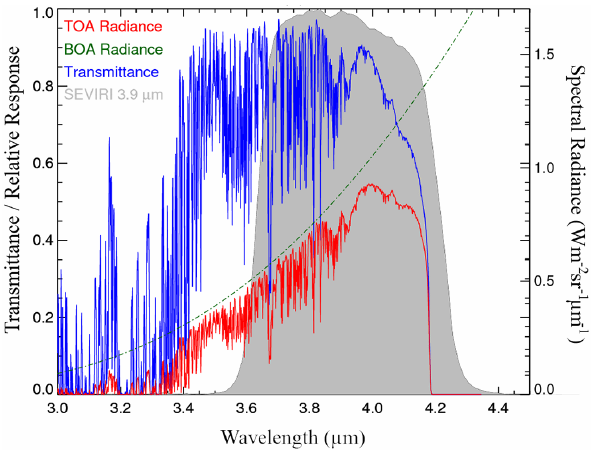
Figure 10. SEVIRI IR3.9 (MWIR) band spectral response function, with example atmospheric transmittance calculated across the 3.0– 4.5µm wavelength range assuming a standard atmosphere (Berk et al., 2005), plotted on the left y axis. Also shown, plotted on the right y axis, are the bottom-of-atmosphere (BOA) thermal emittance for a 310K blackbody, along with the top-of-atmosphere (TOA) equiv- alent after the emitted radiation has passed through the interven- ing atmosphere to space. Simulations performed using the MOD- TRAN5 radiative transfer code (Berk et al., 2005 and the US stan- dard